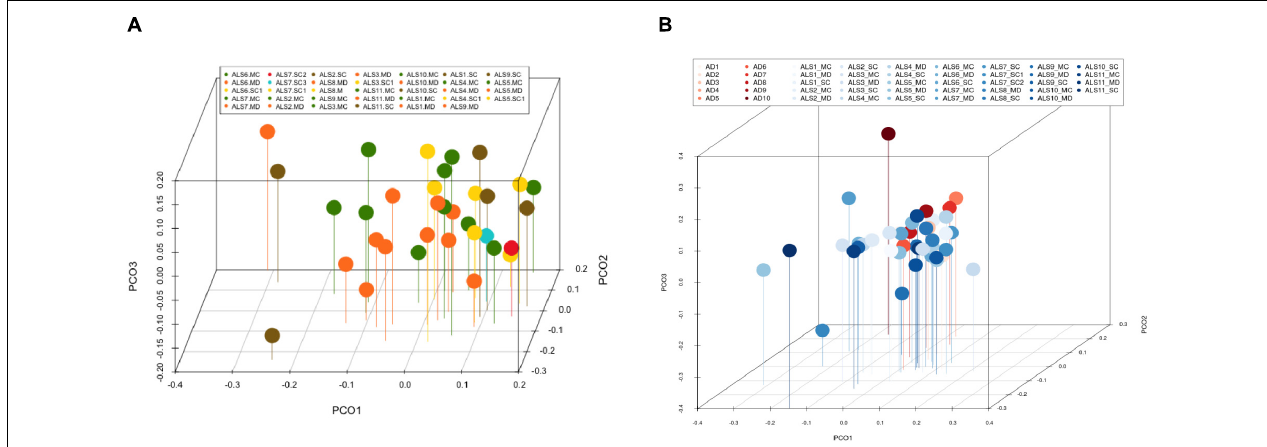
FIGURE 3 | Principal component analysis of bacteria of CNS regions from ALS patients and AD patients. (A) Three-dimensional (3D) principal component analysis (PCA) between different CNS regions from 11 ALS patients. (B) 3D PCA between ALS and AD patients. MC, motor cortex; MD, medulla; SC, spinal cord, SC1, SC2, and SC3, three samples from different regions of the spinal